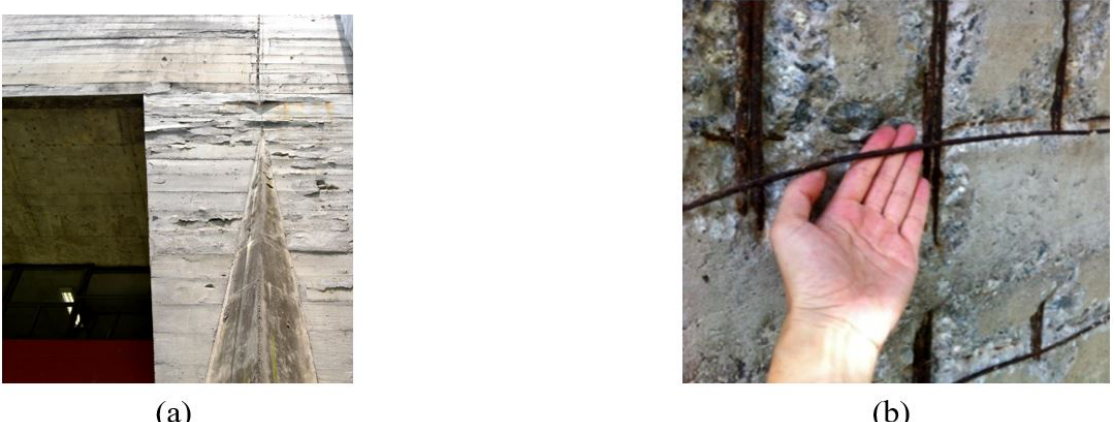
Figure 2. Partial view of NE façade: (a) area with concrete disaggregation on pillar P3 and (b) exposure of corroded reinforcement steel (Photos: authors’ collection,